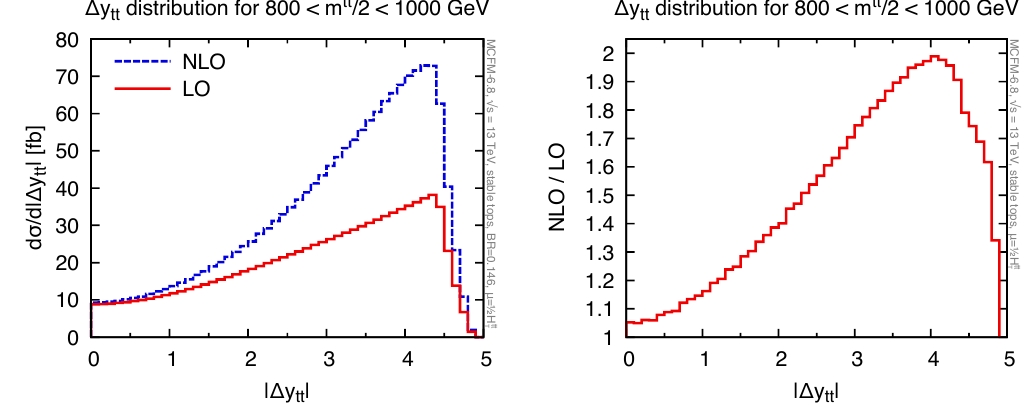
distribution in a bin of large m t ¯ t / 2 , t ¯ t / 2 . Right: corresponding K-factor, i.e. T